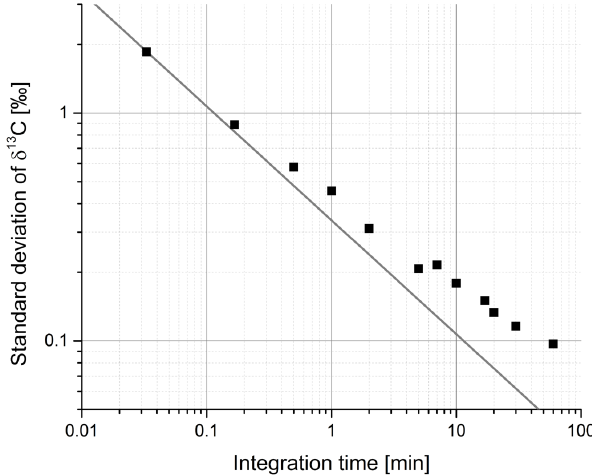
Fig. 2. Standard deviation for the measurements of CBDS-48 us- ing constant flow from a single cylinder, using different integration times. The grey line gives the theoretical predication for random (white) noise.